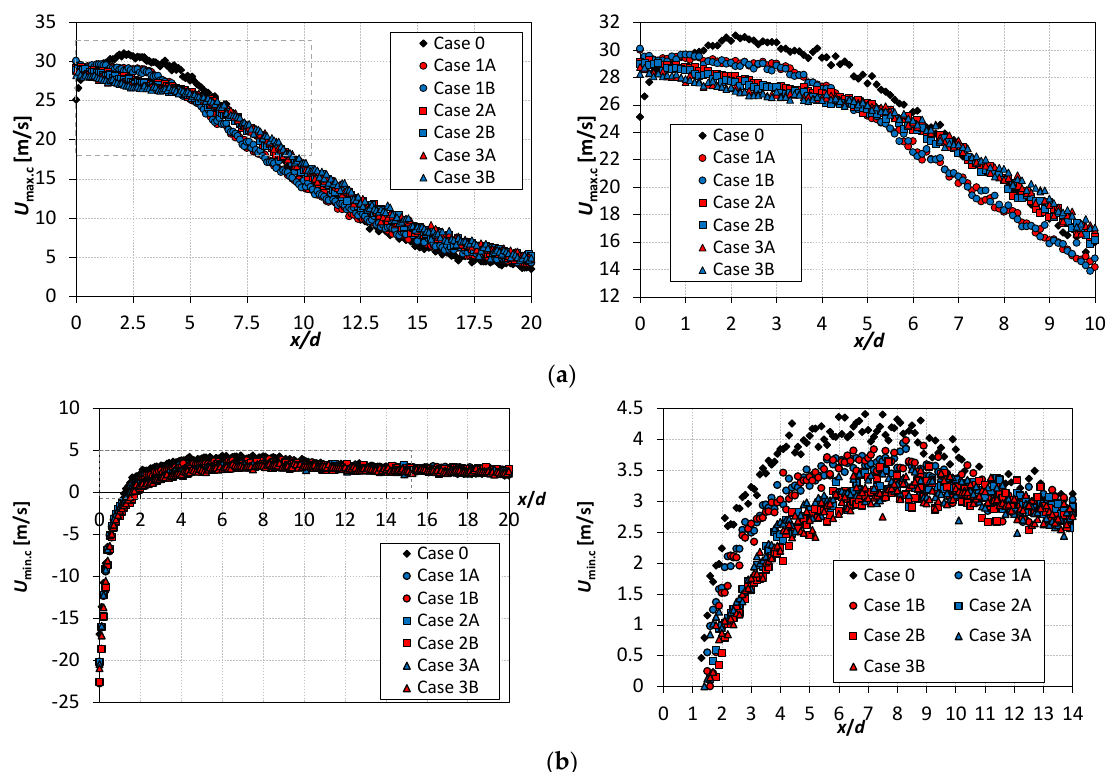
Figure 11. The maxima ( a ) and minimal ( b ) centerline velocity as a function of axial distance x/d and close-ups on selected areas of the charts, at the characteristic frequency and real power p = 5 W.